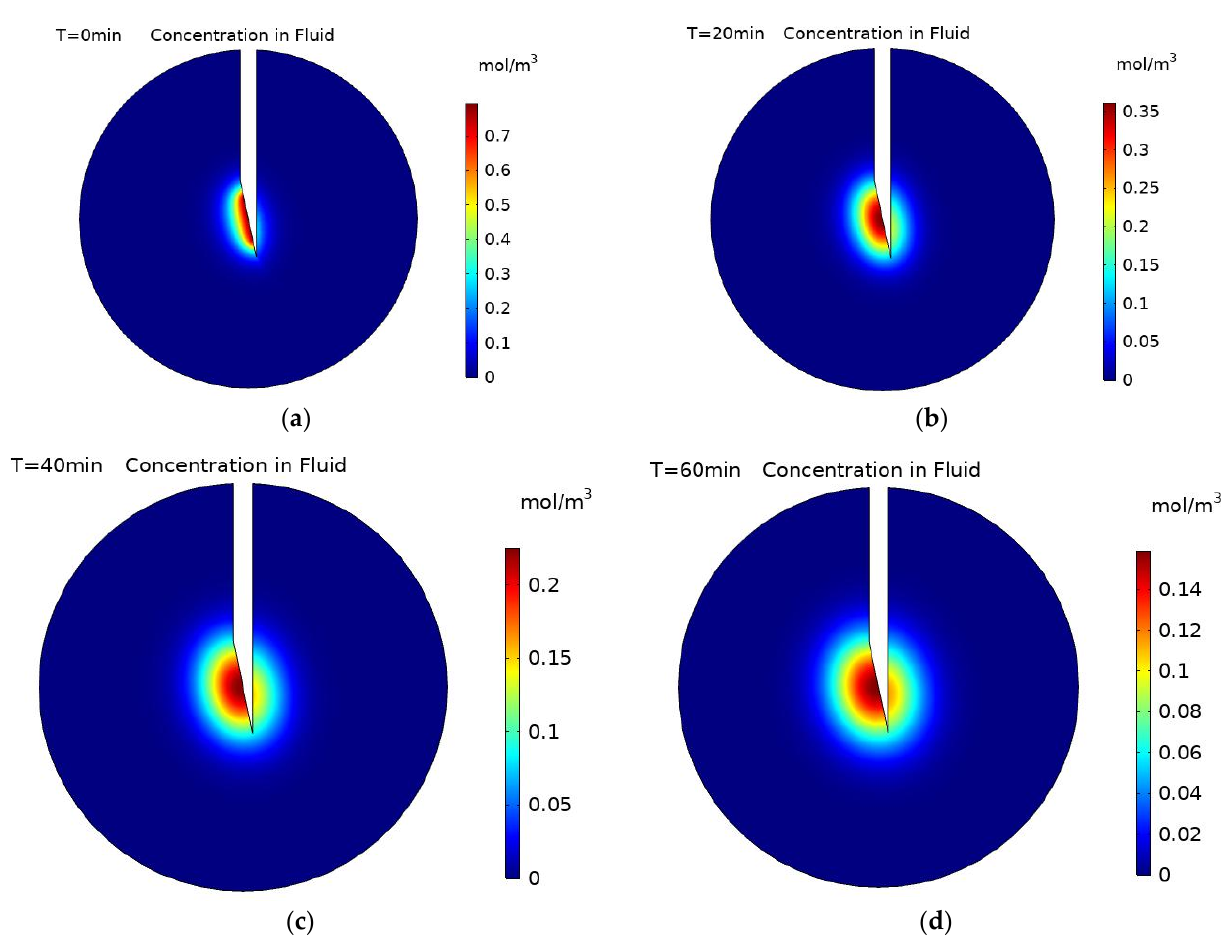
Figure 10. Concentration contours of uncharged nanoparticles within the fluid at; ( a ) 0 min, ( b ) 20 min, ( c ) 40 min, and ( d ) 60 min post-injection.